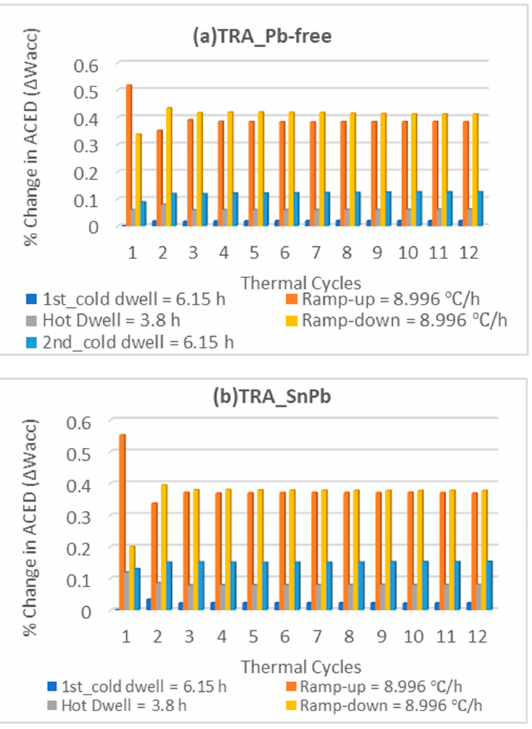
6a Figure 5. Change in ACED distribution from TRA thermal cycle for: ( a ) Pb-free ( b ) PbSn intercon-